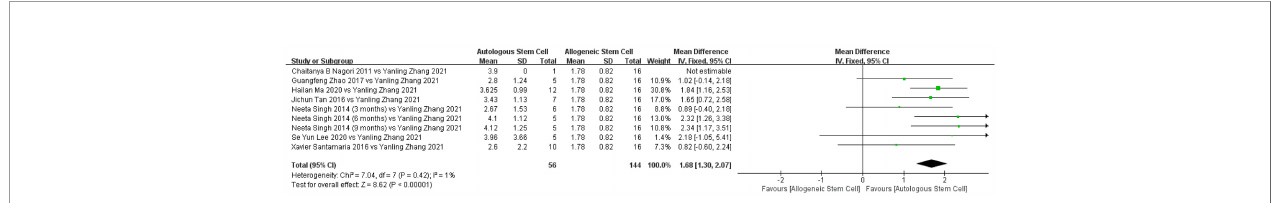
FIGURE 7 | Comparison of endometrium improvement of autologous and allogeneic stem cells in treatment of